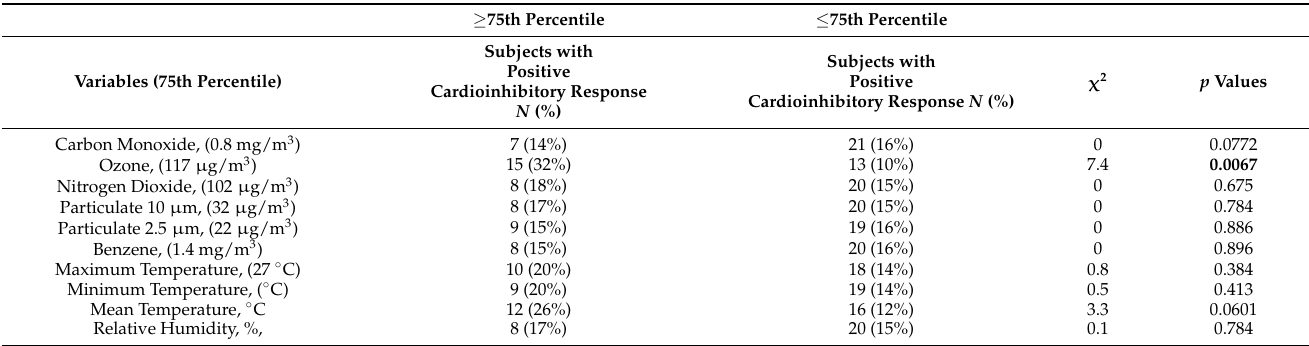
Table 3. Pollutants’ concentrations ( ≥ 75th percentile or ≤ 75th percentile) in patients with positive CSM and cardioinhibitory